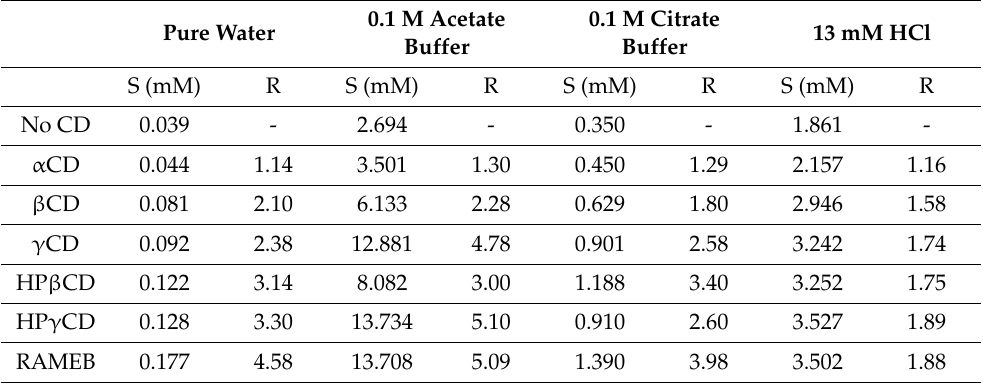
Figure 1. Carvedilol’s solubility in various media at room temperature and in the presence or absence of 10 mM CDs: pure water ( ), 0.1 M citrate buffer (pH = pKa 2 = 4.7) ( ), 13 mM HCl (pH ~3.5) ( ), 0.1 M acetate buffer (pH = pKa = 4.7) ( ). The rescaled Y axis from (carvedilol) = 0 mM to 2 mM has been included, to show the compound’s solubility in pure water. Table 1. Carvedilol’s solubility (S, mM) and its enhancement (R ratio) by CDs (10 mM) relative to carvedilol alone in the same medium.